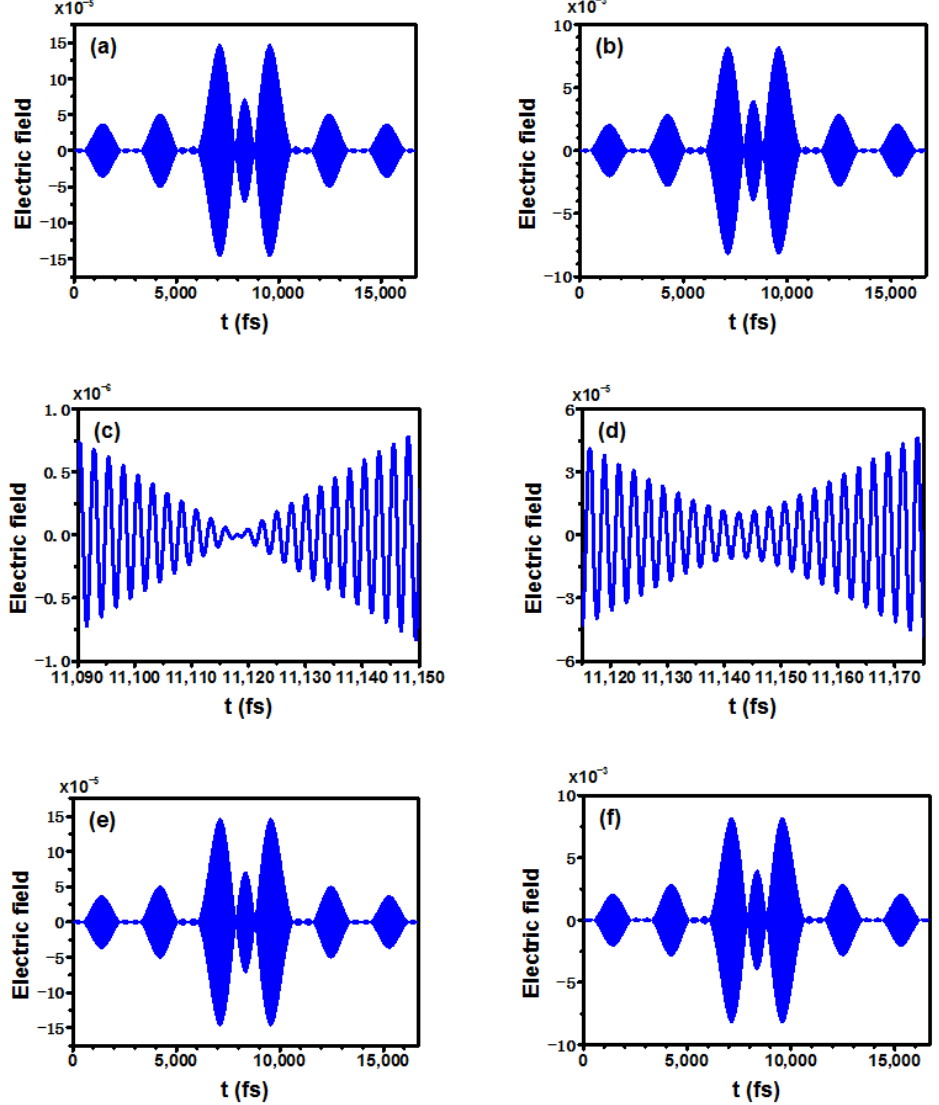
Figure 7. ( a – d ) Real and ( e , f ) imaginary parts of the electric field of the pump pulse; ( a , c , e ) the input pulses; and ( b , d , f ) the output pulses at the probe point of the disk-ring structure. ( c ) is an enlarged view of ( a ) in the range of 11,090–11,150 fs. ( d ) is the response of the pulse in ( c ), i.e., the pulse in the range of 11,115–11,175 fs in ( b ).